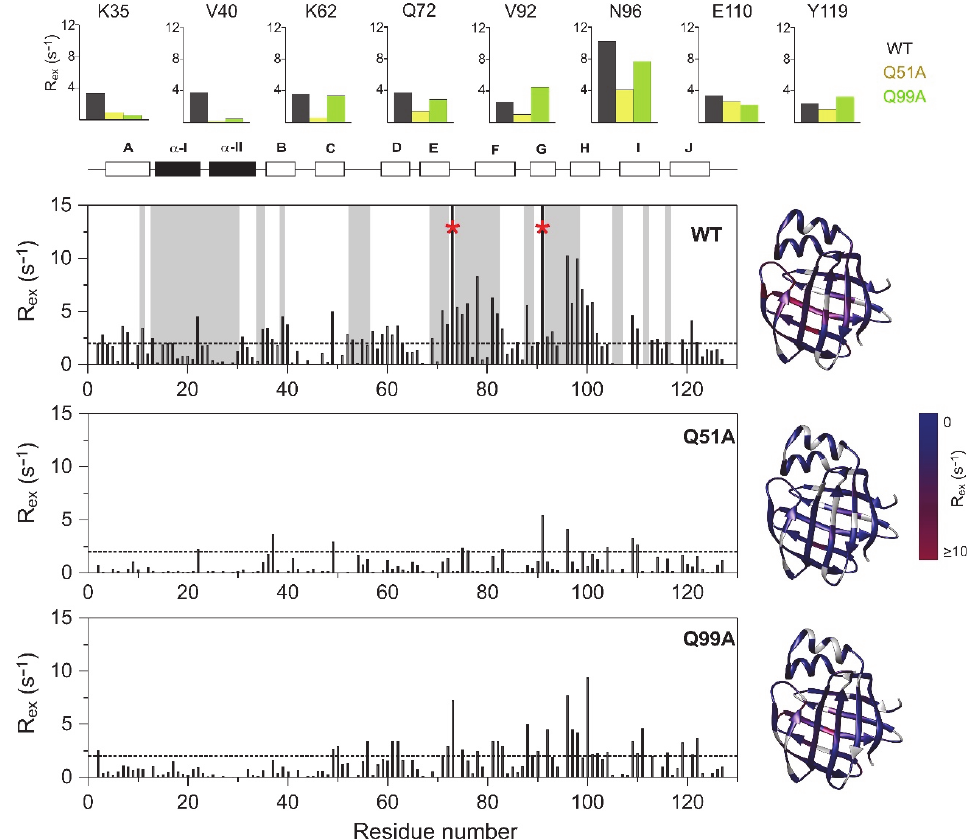
Figure 5. Values of 15 N R ex (at a static magnetic field strength of 14.1 T) of 2 H/ 15 N-labeled wild-type ( top ), Q51A ( middle ), and Q99A ( bottom ) apo human I-BABP at 283 K (pH = 6.3) as a function of amino acid sequence. R ex was estimated from the difference in R 2 eff at the lowest and highest ν CPMG values. Residues displaying a C α positional difference between the apo and the heterotypic double-ligated holo form larger than 2 Å are shown in a gray background. Residues exhibiting a R ex > 15 Hz are marked with a red asterisk. Secondary structural elements are indicated at the top. For representative residues, 15 N R ex in the investigated human I-BABP variants are shown in large at the top (WT: black, Q51A: yellow, Q99A: green). Values of R ex are mapped on the ribbon diagram of wild-type human I-BABP (PDB entry 1O1U [15]) in a blue-to-red gradient on the right for each